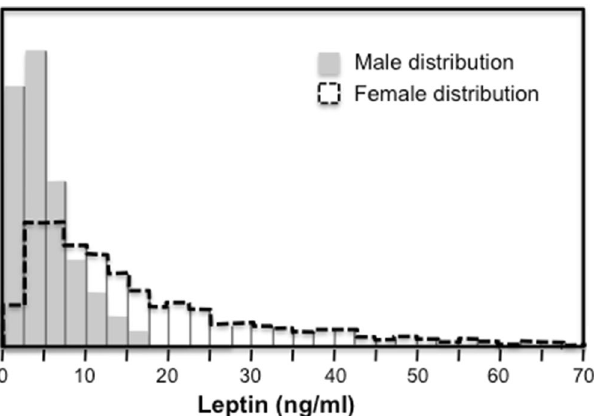
Figure 4. Distribution of plasma leptin concentrations in Framingham Heart Study women and men. The area under each curve represents the percentage of the distribution. For example, 10 percent of the males had leptin concentration ≤ 1.38 ng/ml, 50 percent were ≤ 4.20 ng/ml and 90 percent were ≤ 12.52 ng/ml. For women, 10 percent had leptin concentration ≤ 3.38 ng/ml, 50 percent were ≤ 11.97 ng/ml, and 90 percent were ≤ 41.10 ng/